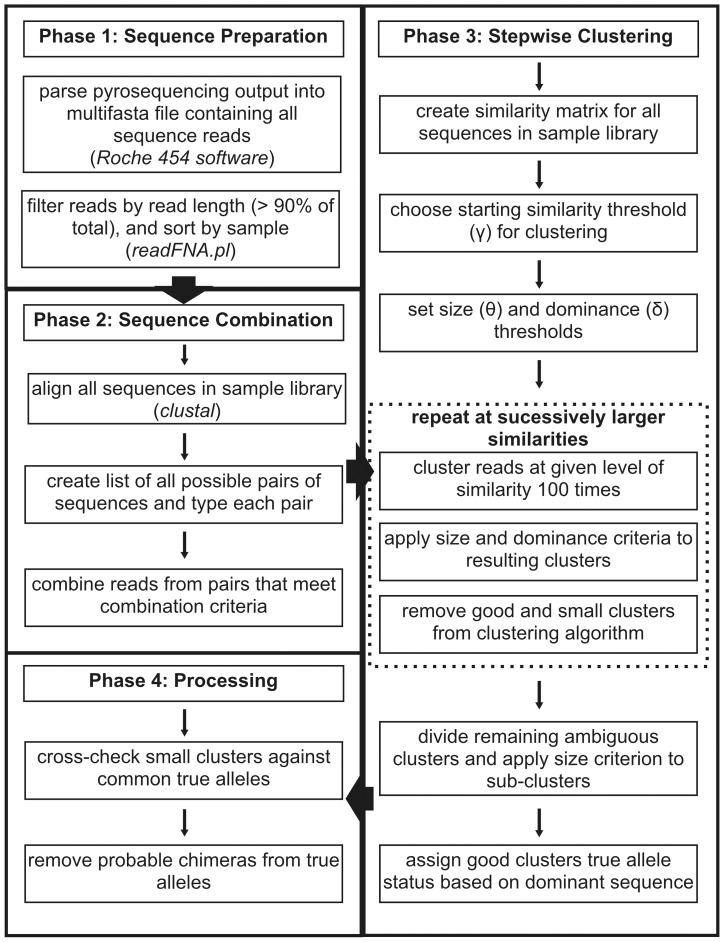
Outline of steps in STC genotyping.Programs and software used to implement each step are given in italics. The initial sff file was parsed using proprietary Roche software at the University of Texas Genome Sequencing and Analysis Facility. Filtering of reads and parsing samples by barcodes was accomplished using a custom perl script. Phases 2–4 were implemented in a custom R script. All scripts necessary for running STC have been uploaded to the Dryad Digital Repository (http://dx.doi.org/10.5061/dryad.4fn4g)